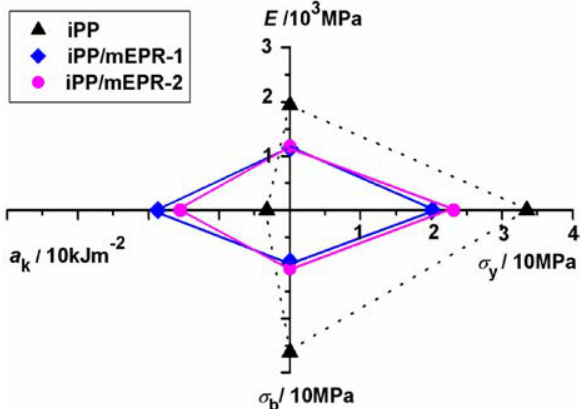
Figure 10 . Optimization diagram of mechanical properties of iPP/ m-EPR blends with 20 vol.% of added